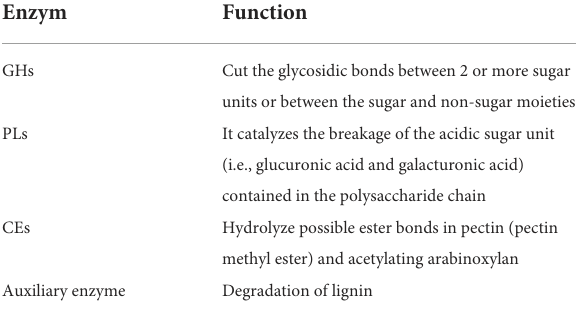
TABLE 1 Function of four classes of carbohydrate-active enzymes encoded by intestinal